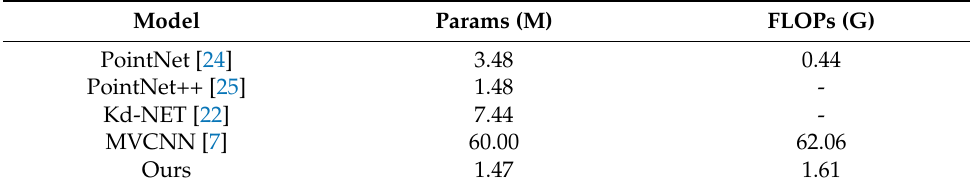
Table 3. Space complexity and time complexity for classification.